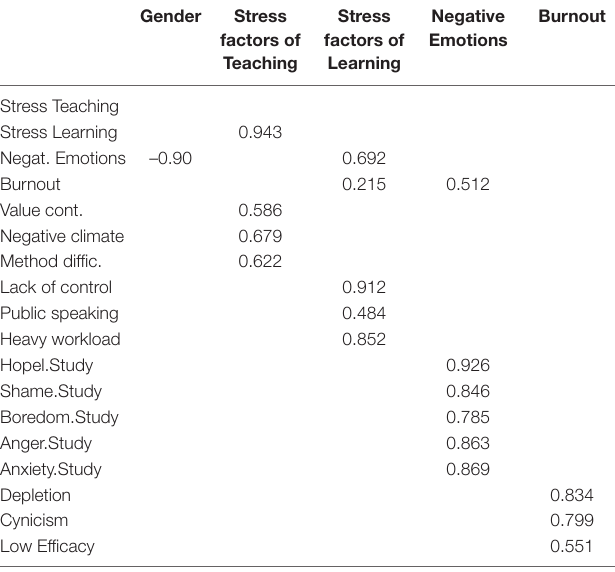
TABLE 2 | Standardized Direct Effects of prediction.